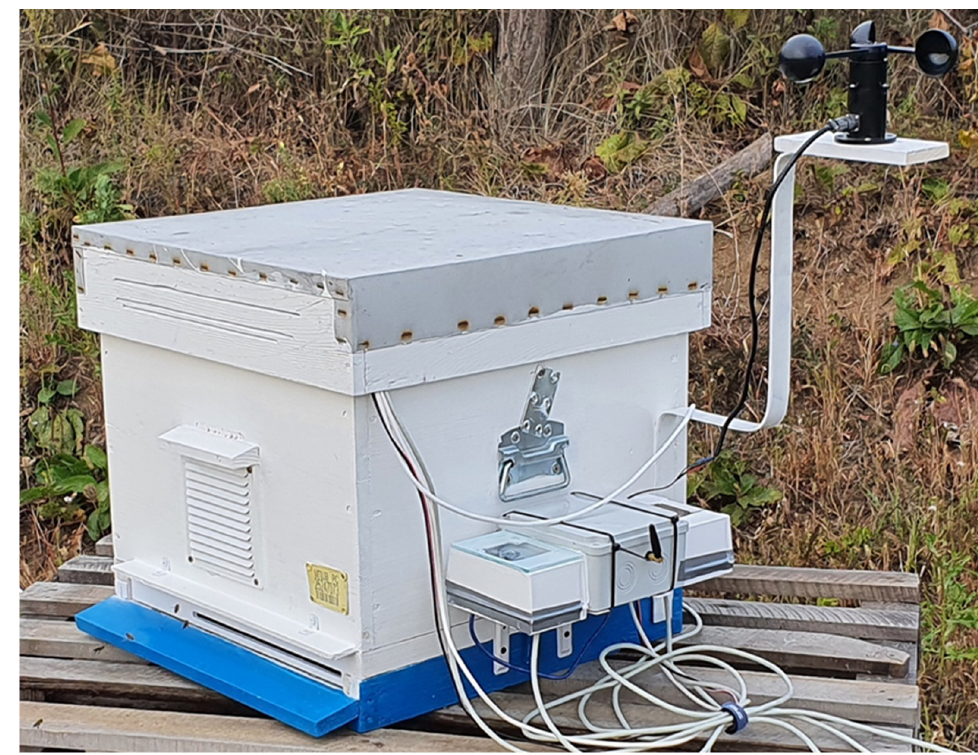
Figure 2. Experimental hive setup with sensor electronics.